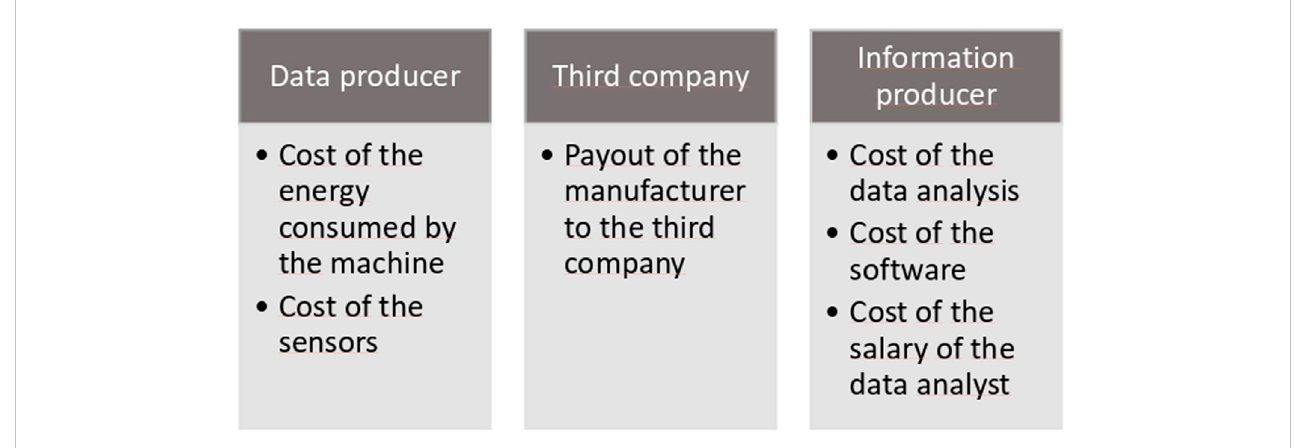
FIGURE 1 Data marketplace players and the elements affecting the production cost of